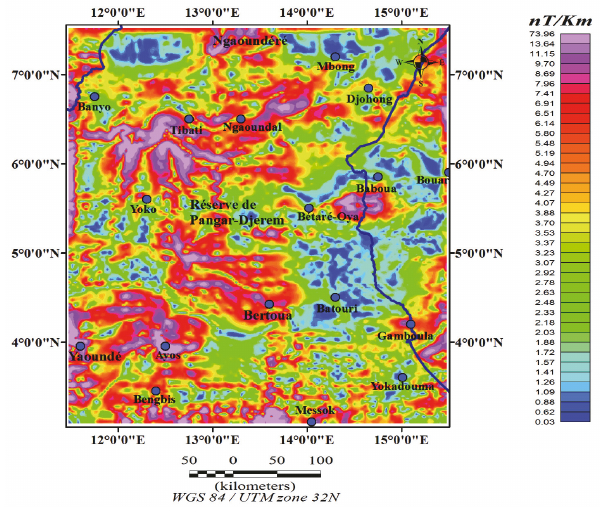
Figure 6: Horizontal gradient magnitude of TMI-RTE map upward at 4 km.